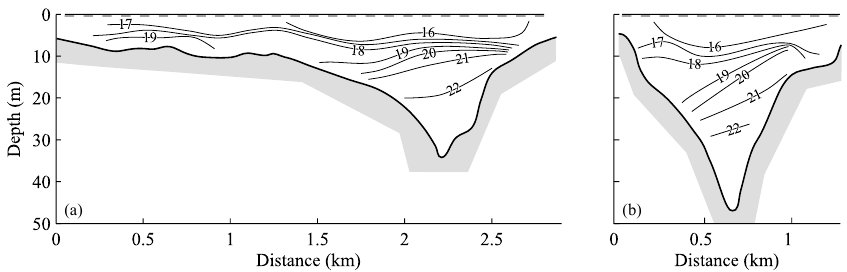
Figure 5. Cross-strait transects of observations of density (minus 1000kgm − 3 ) given by contour lines. The transects were made using a ScanFish (see text) along the two cross-strait survey lines just north of the narrow part of the Little Belt as shown in Fig. 1. The transects were made on 16 June 2004 from 09:45 to 10:56UTC. The northern transect is shown in (a) , the southern in (b) , and in both cases the length axes are pointing from north-west to south-east.